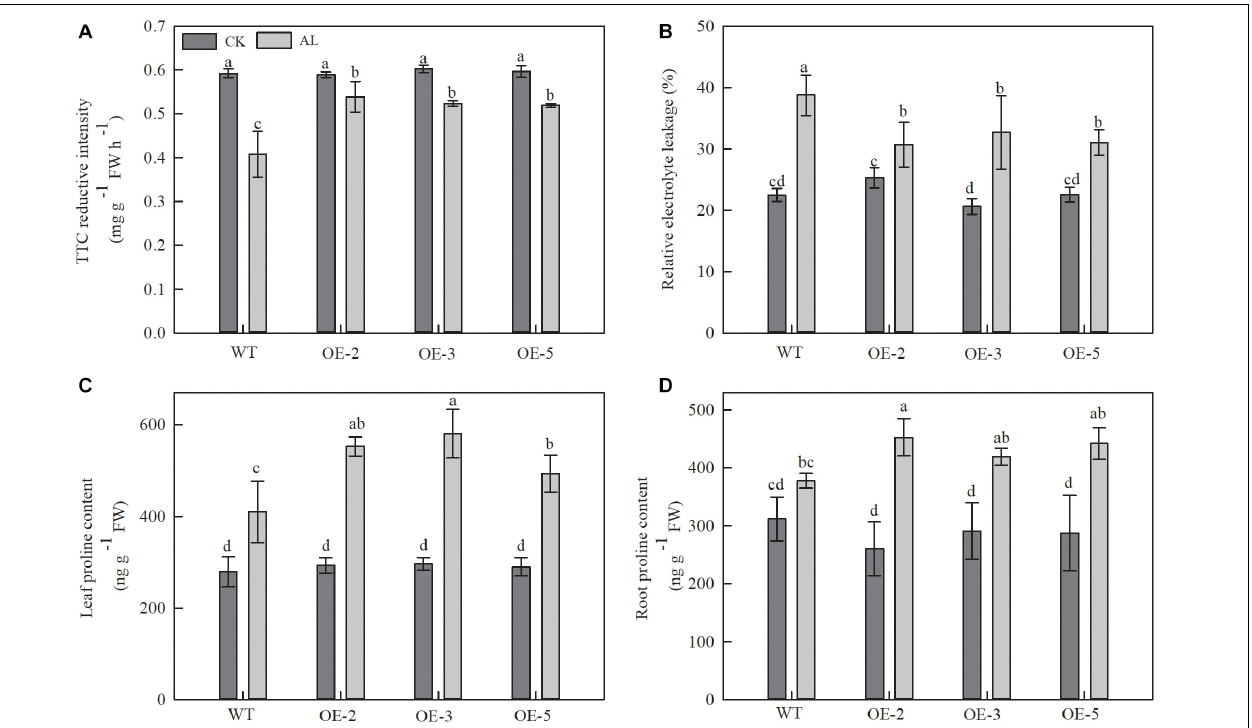
FIGURE 2 | Overexpression of MdTyDc had an effect on the root development, REL and proline content after 15 days under control and alkaline conditions. (A) The root activity, (B) leaf relative electrolyte leakage (REL), (C) leaf proline content, and (D) root proline content. The data are presented as means ± SD ( n = 3). Significant differences between WT and MdTyDc overexpression lines are indicated by different lowercase letters based on Tukey’s multi-range test ( P < 0.05). WT, wild type. OE-2, MdTyDc overexpression line 2. OE-3, MdTyDc overexpression line 3. OE-5, MdTyDc overexpression line